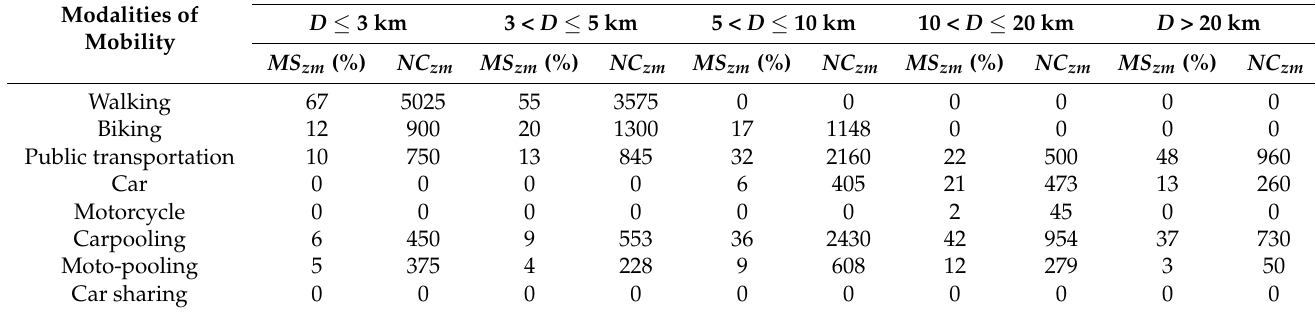
Table 5. SCENARIO 1 —share of commuters by zone and modality ( MS’ zm ) and related numbers ( NC’ zm ) per zone and per modality.